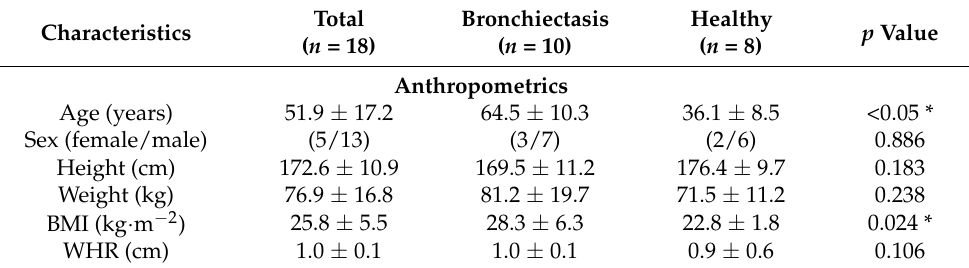
Table 1. Baseline anthropometrics of adults with bronchiectasis and healthy